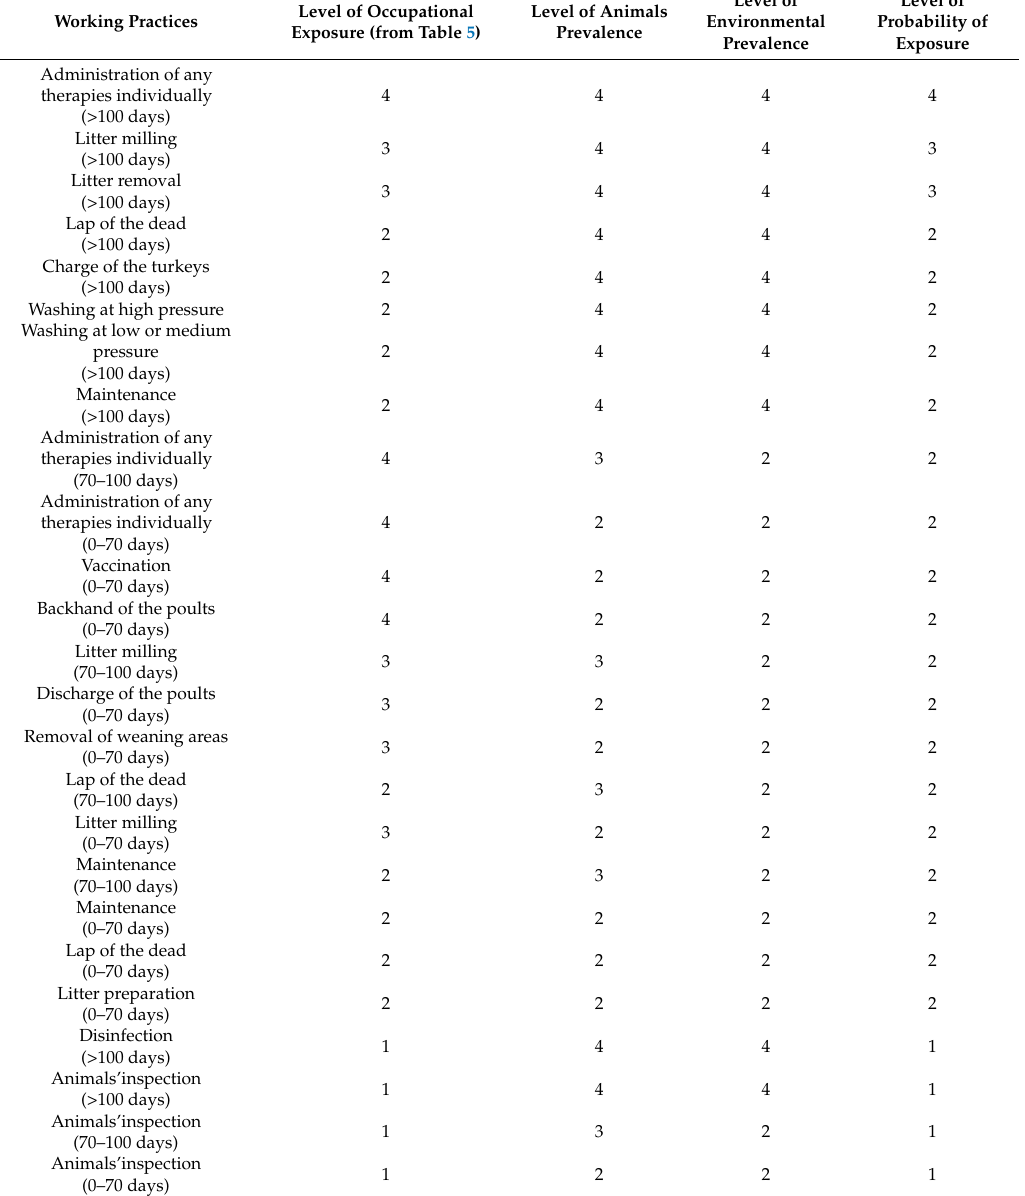
Table 11. Probability level of exposure to MRSA in descending order for each of the working practices in the fattening turkey farming, as obtained through a modified FMEA. When two or more practices have the same ranking they are ordered according to the tie-break